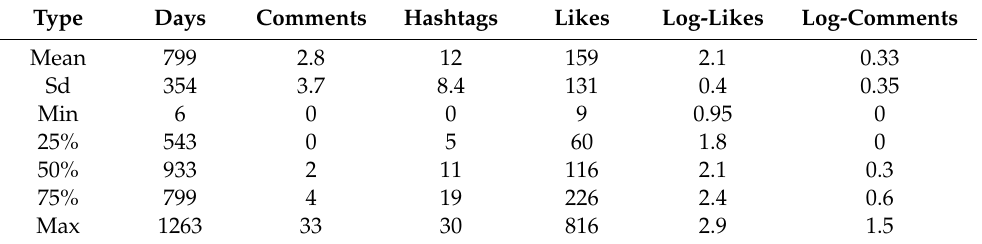
Table 1. Descriptive Statistics of Meta data-based features and outcome variables.